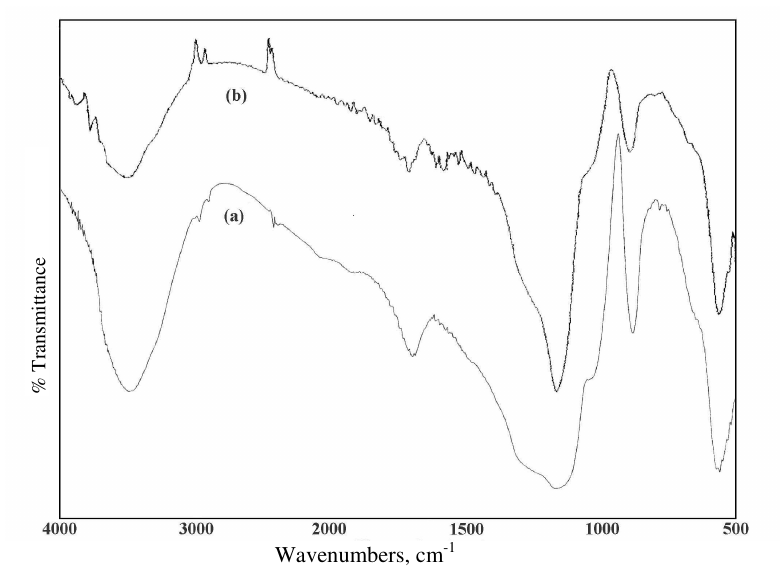
Figure 1 . FTIR spectra of (a) CCS (b) CCS with fluoride.